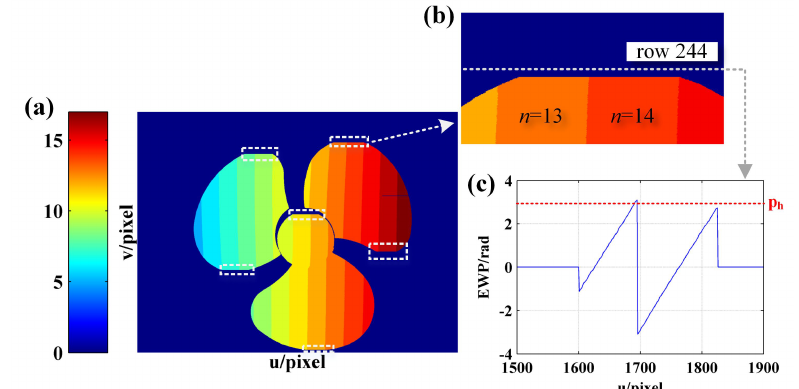
Figure 16. ( a ) The preliminary phase order map; ( b ) partial EWP with u = [1500, 1900] and v = [150, 350]; ( c ) EWP with u = [1500, 1900] of row